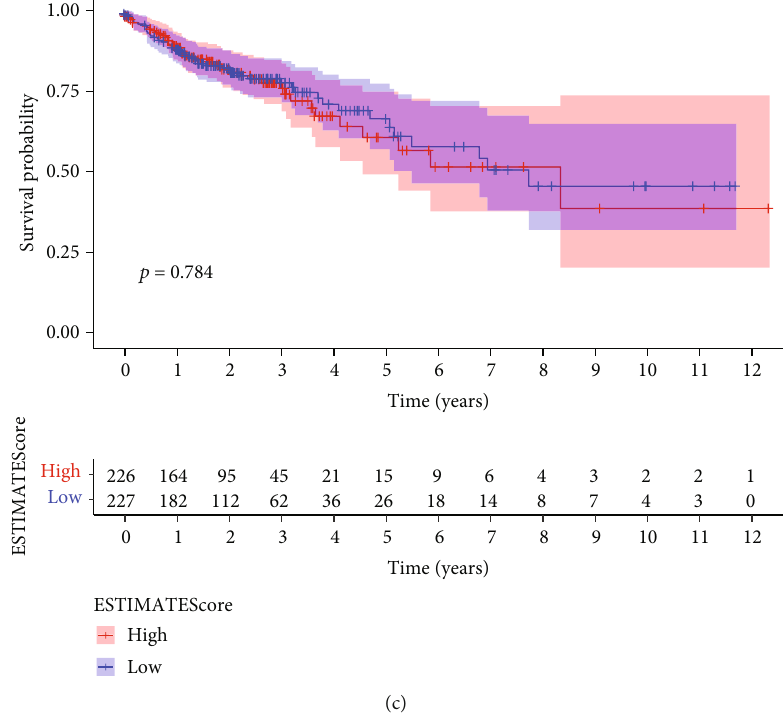
Figure 1: Relationships of ESTIMATEScore, StromalScore, and ImmuneScore with survival in CRC patients. Kaplan-Meier survival investigations of CRC patients su ff ering from low and high (a) ImmuneScores, (b) StromalScores, and (c)